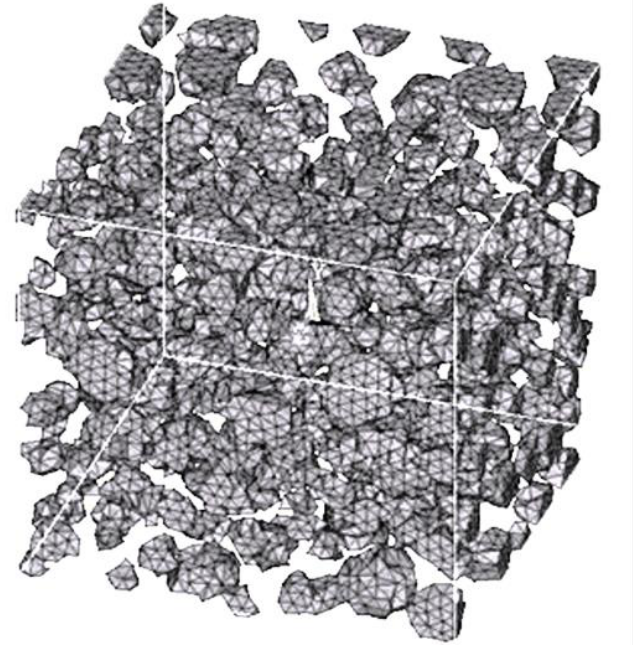
Fig. 9. Fine representation of stones geometries within the cubical